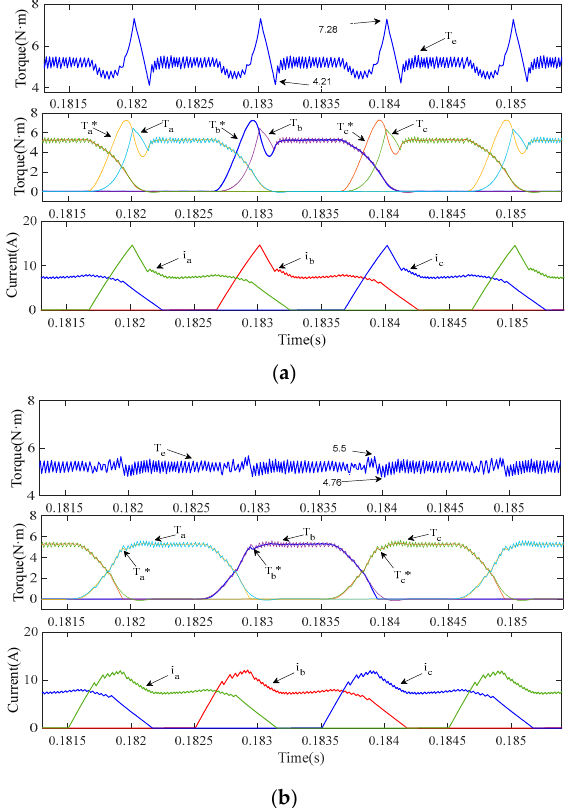
Figure 13. Simulation waveforms of torque and current: ( a ) conventional TSF scheme at 1000 r/min; ( b ) proposed NUTSF at 1000 r/min.